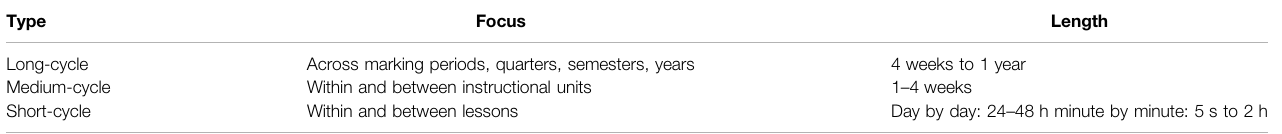
TABLE 1 | Short-, medium-, and long-cycle lengths for formative assessment.